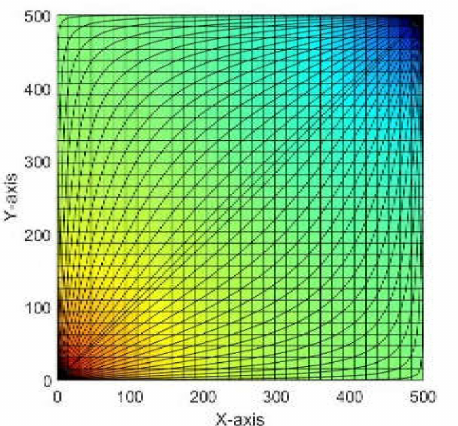
Figure 1. Solution of the quarter-five spot problem on a 32 × 32 uniform grid. The plot shows the pressure distribution on each point in the grid, where the highest pressure values are in the bottom left corner and the pressure decreases gradually until it reaches the lowest value at the top right